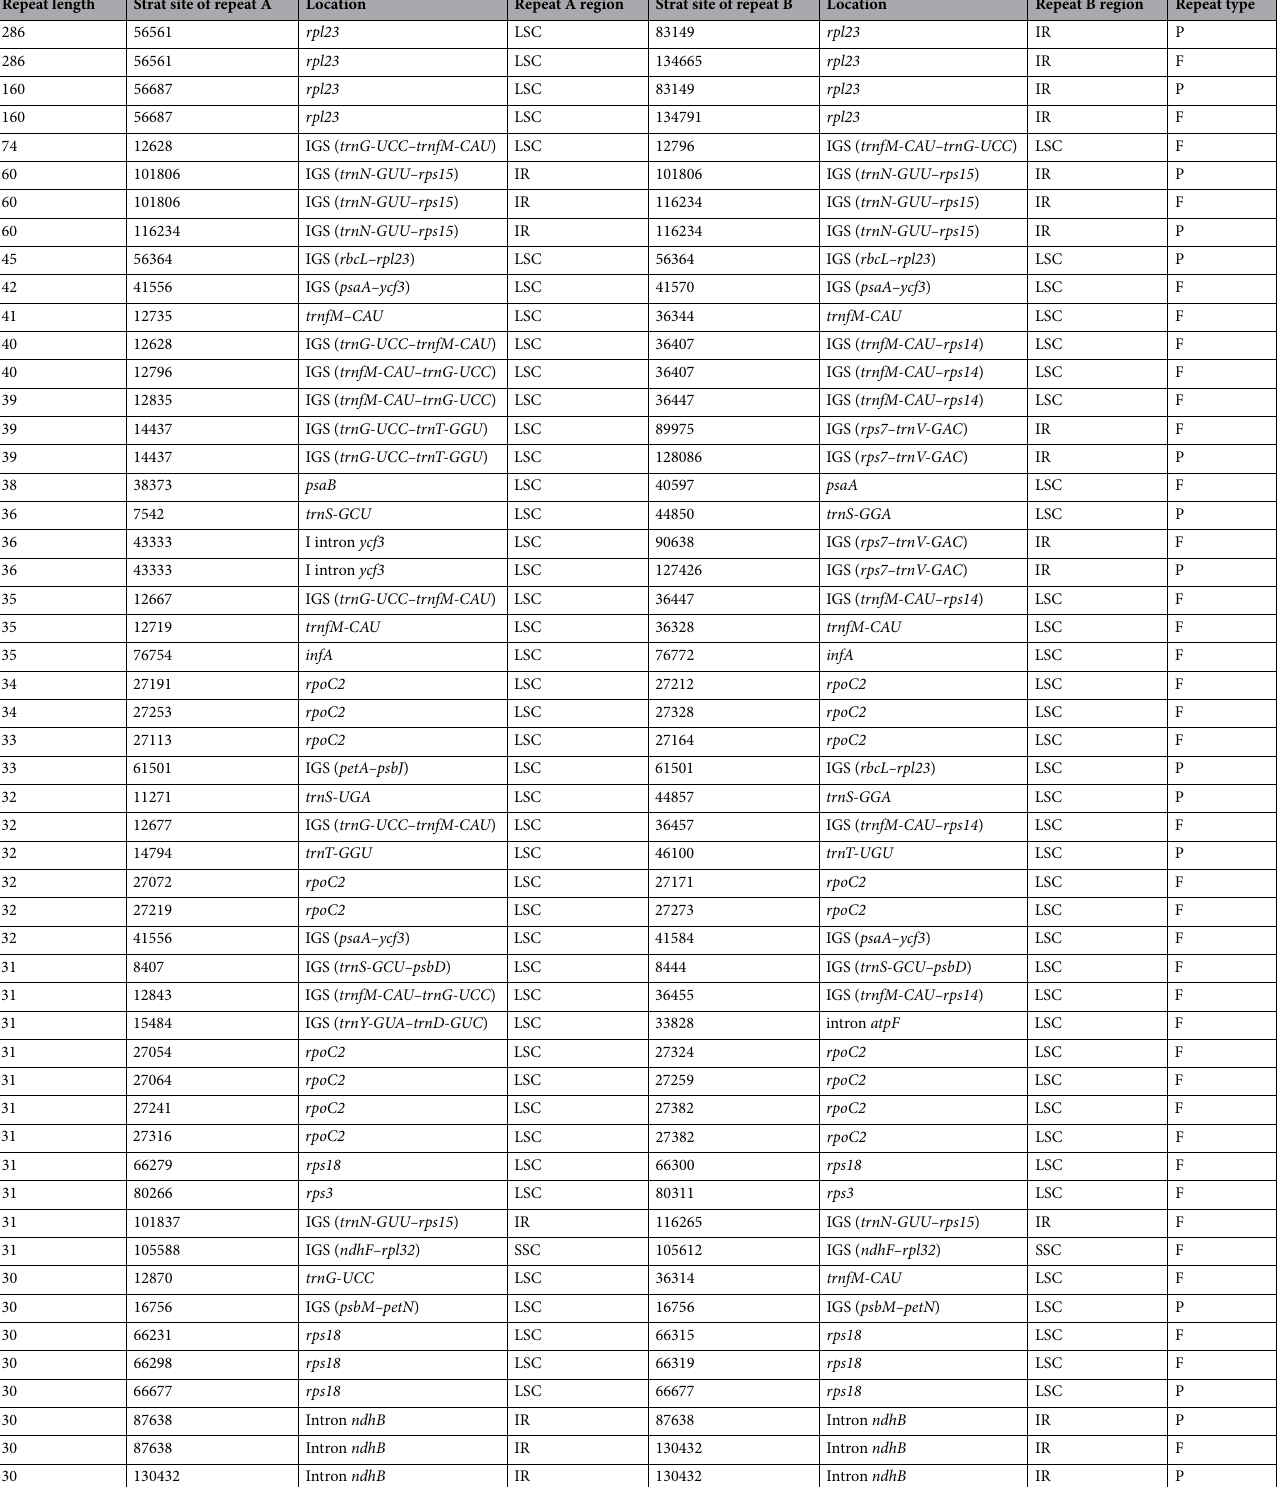
Table 2. List of repeated sequences in the chloroplast genome of Secale cereale ssp. segetale. IGS ( trnG-UCC– trnfM-CAU ) means spacer between trnG-UCC and